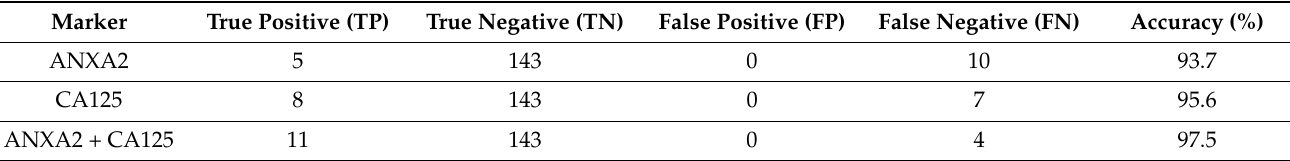
Table 2. Accuracy (%) of ANXA2, CA125 and ANXA2 + CA125 calculated from the proportion of true positives, true negatives, false positives and false negatives in stage IA OC ( n = 15) versus healthy controls ( n =